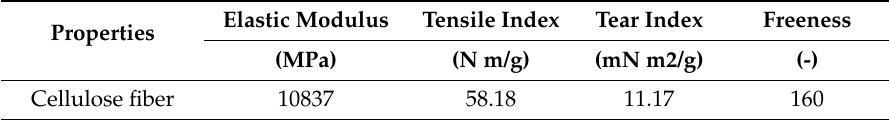
Table 1. Morphological properties of the cellulose fiber.